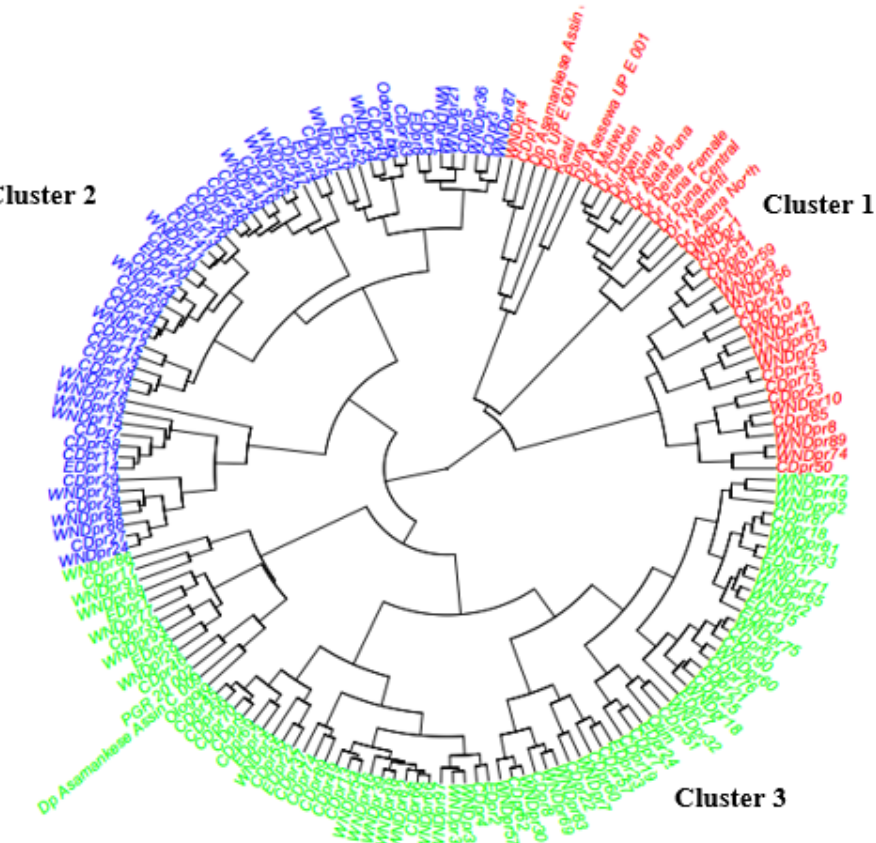
Figure 3. Hierarchical dendrogram showing grouping patterns of D. praehensilis and D. rotundata genotypes using nine key agronomic and tuber quality traits based on the Gower dissimilarity matrix. Red, blue and green colours indicate Cluster 1, Cluster 2 and Cluster 3, respectively.